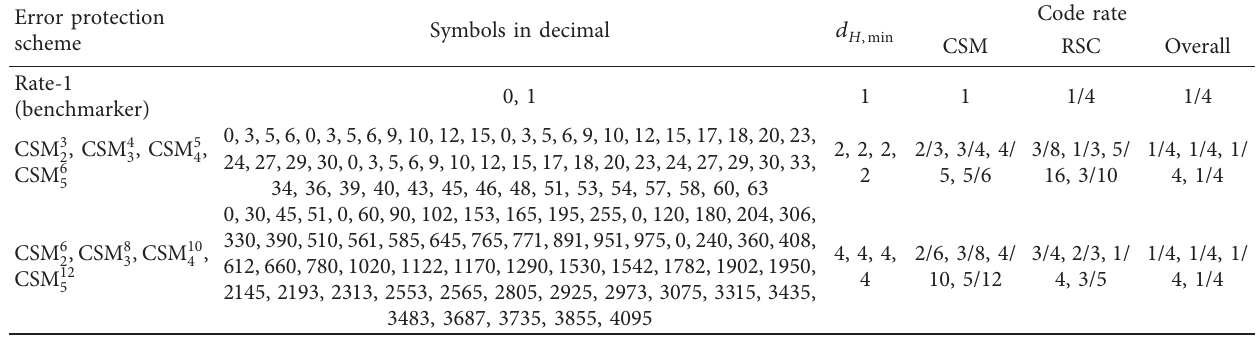
Table 3: CSM-coded symbols with d H, min and corresponding code rates of constituent encoders.